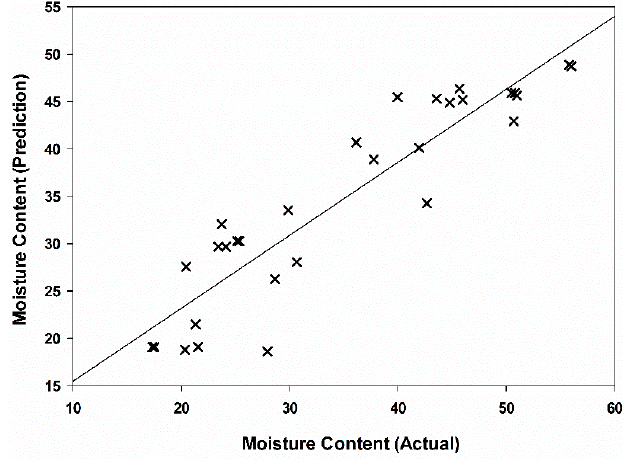
Figure 6. Relationship between actual and predicted moisture content based on linear calibration model at 100 kHz.